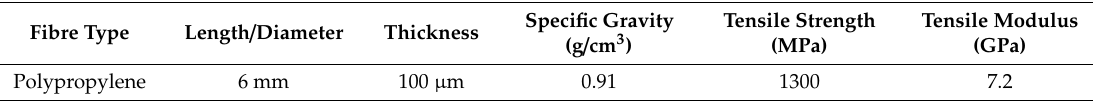
Table 1. Mechanical properties of the polypropylene (PP) fibre that has been used in the mortar mix.